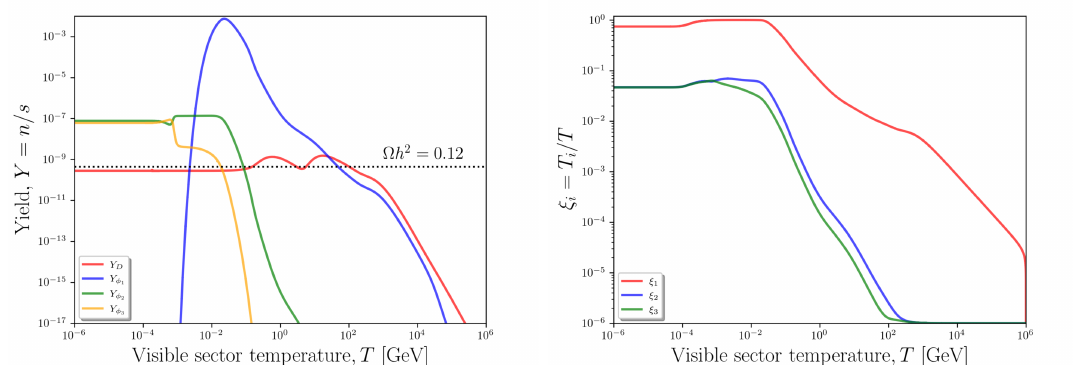
Figure 2. The case of three initially cold dark sectors. Left panel: evolution of the yields of the dark fermion D and of the spin zero particles of the dark sector versus the visible sector temperature. Right panel: evolution of the temperature ratios ξ i . The input parameters are: m D = 1 . 0 GeV, m φ = 50 MeV, m φ = m φ = 1 MeV, y f = 1 . 3 × 10 − 9 , y D = 0 . 053 and κ 1 = κ 2 = 10 − 6 . Total 1 2 3